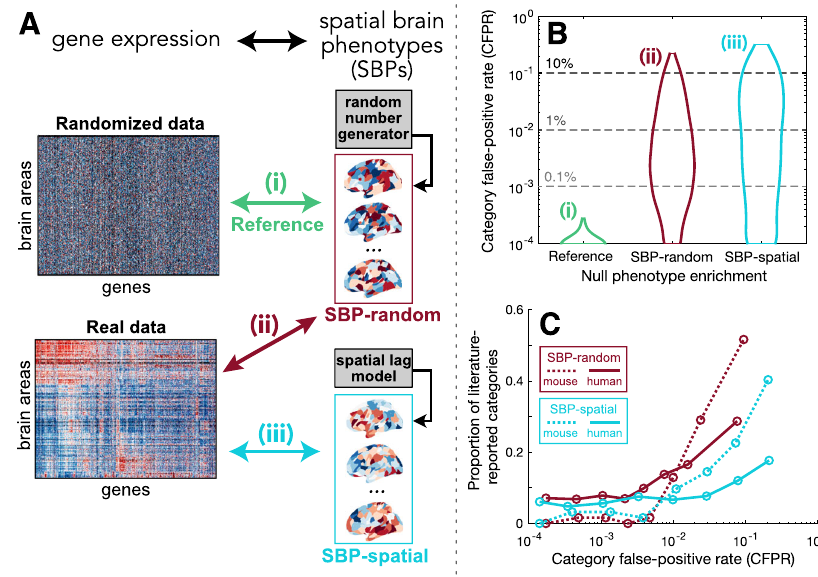
Fig. 2 Some GO categories have far higher false-positive rates under randomized spatial phenotypes than statistical expectation, and these GO categories are more likely to be reported as signi fi cant in published studies. A A schematic of three GCEA analyses involving correlations between (i) “ reference ”— an ensemble of random phenotypes and randomized gene-expression data (green), (ii) “ SBP-random ”— an ensemble of random phenotypes and real gene-expression data (red), and (iii) “ SBP-spatial ”— an ensemble of spatially autocorrelated phenotypes and real gene-expression data (blue). For the human cortex, examples of spatial maps in each ensemble are plotted; relative to the SBP-random maps that have no spatial correlation structure, the SBP-spatial maps are more likely to have similar values in nearby locations. B Distributions of the category false-positive rate (CFPR) across all GO categories are shown as violin plots in mouse. Across an ensemble of 10,000 SBP-random or SBP-spatial maps, the CFPR is computed for each GO category as the proportion of phenotypes for which that GO category was found to be signi fi cant. Results are shown for the three analyses depicted in A : (i) “ reference ” (green); (ii) “ SBP-random ” (red); and (iii) “ SBP-spatial ” (blue). Note the logarithmic vertical scale (and therefore exclusion of GO categories with CFPR = 0). C The proportion of literature-reported GO categories increases with the CFPR estimated from random phenotypes. GO categories were labeled from a literature survey of GCEA analyses using atlas-based transcriptional data in human and mouse (see Supplementary Information for survey details). Across eight equiprobable bins of CFPR (i.e., each bin contains the same number of GO categories), we plot the proportion of all literature- reported GO categories that are contained in that bin. Results are shown for the SBP-random (red) and SBP-spatial (blue) ensembles in mouse (dotted) and human (solid). The position of each bin is shown as the mean of its